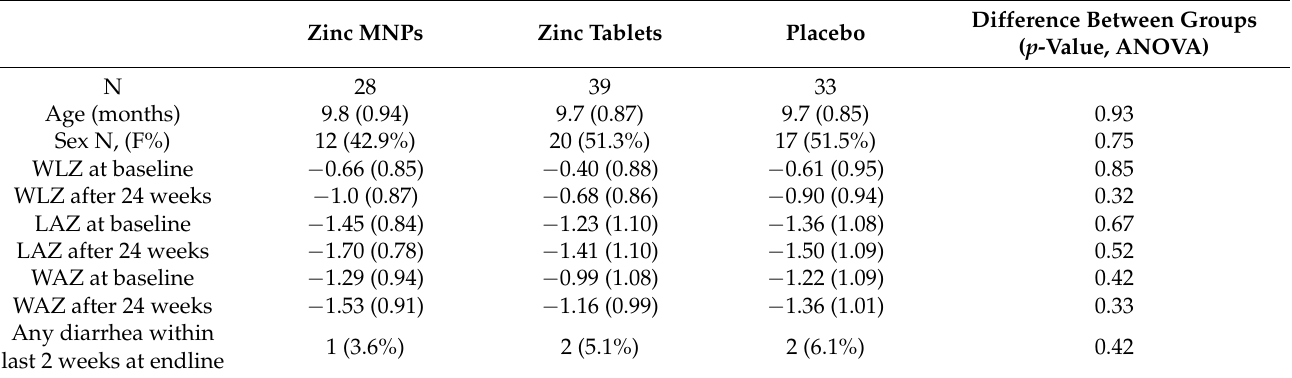
Table 1. Characteristics of